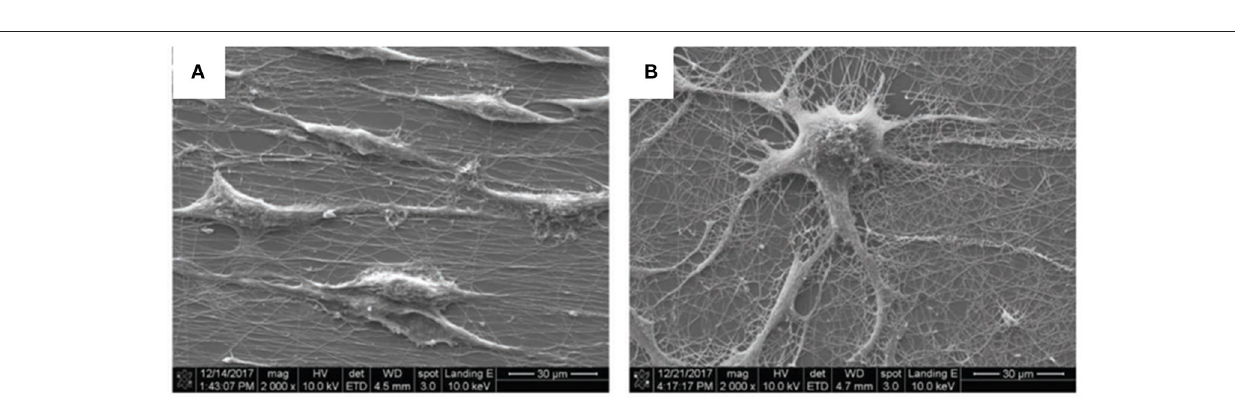
FIGURE 7 | Scanning electron microscopy (SEM) images of (A) aligned and (B) random nanofibres after 5 days of culturing without ES; scale bar: 30 µ m. Reproduced from Tsai et al. with permission from Wiley-VCH Verlag GmbH & Co. KGaA.